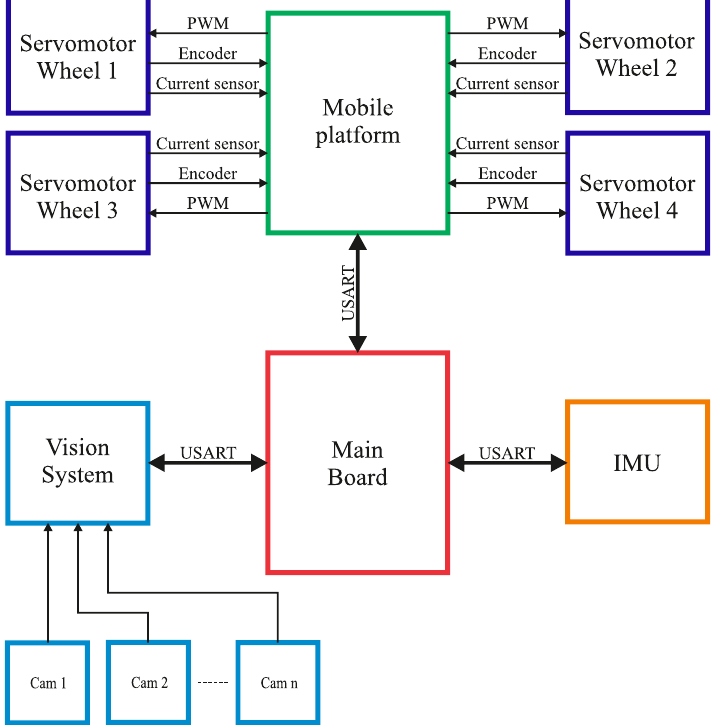
Figure 2. Block diagram of the construction of a mobile vehicle. All algorithms pertaining to the wheels odometry were implemented in C language and are flashed in the STM processor. The vision system was written in C++ language. A photograph of the robot is shown in Figure